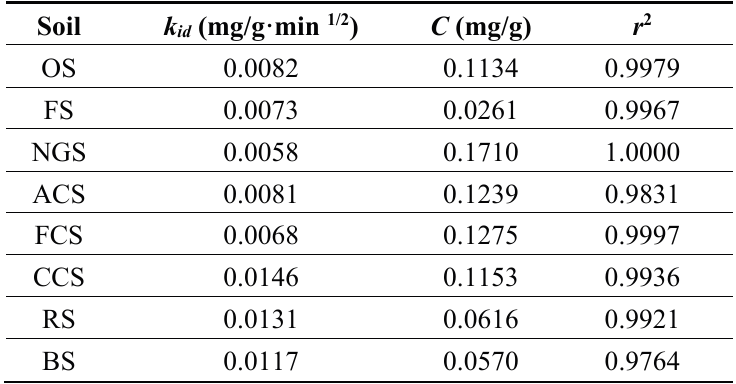
Table 1. Intra-particle diffusion rate constants and intercept values for the adsorption of phosphorus onto